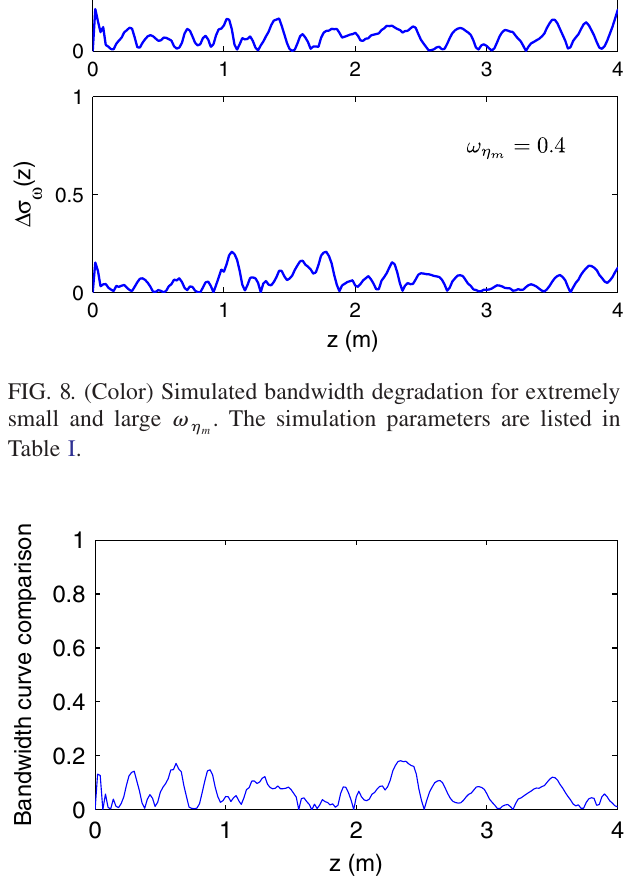
FIG. 9. (Color) The bandwidth difference from two simulations with no initial energy modulation and different random number generator seeds. The simulation parameters are listed in Table